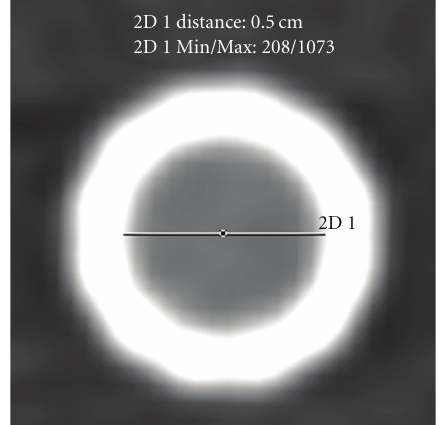
Figure 2: Positioning of the electronic caliper for measuring the visible stent lumen (Wallstent Uni, B40f, result: 5.0 mm).